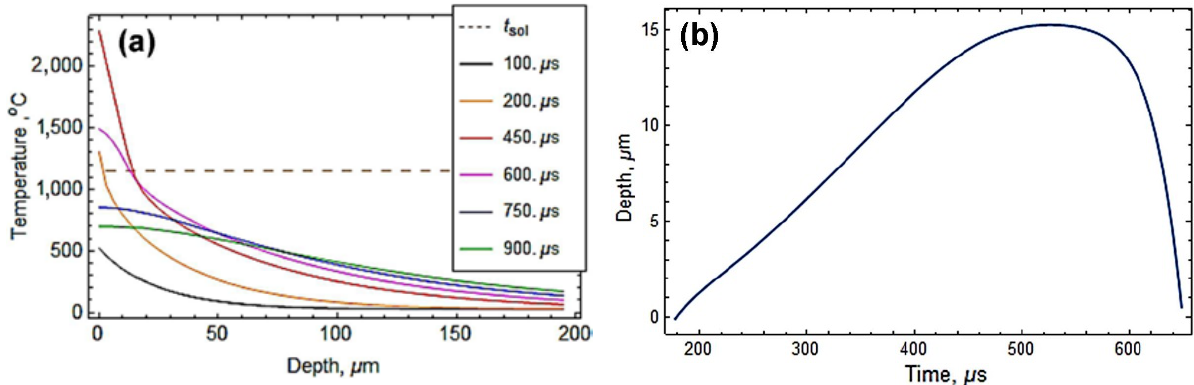
Figure 9. Numerical simulation results of the temperature field of the specimen under plasma heating. ( a ) Time-wise cross-sectional temperature distribution. ( b ) Time dependency of the melting depth (time is given from the contact with the plasma flow).